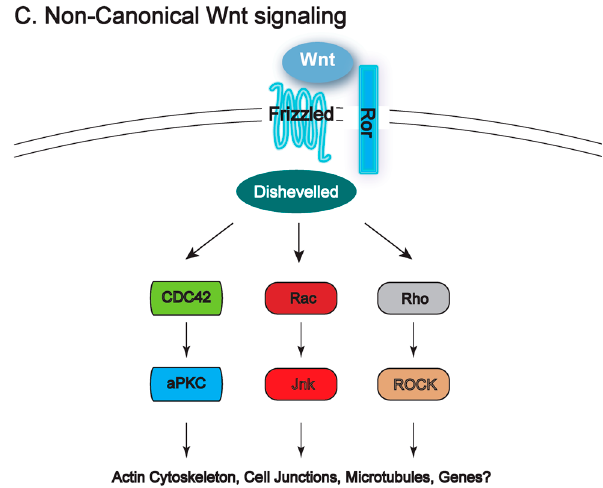
Figure 1. A schematic representation of the Wnt pathway in off ( A ) and on ( B ) conformations and the non-canonical Wnt pathway ( C ). ( A ) In the absence of Wnt ligand, the destruction complex forms in the cytoplasm bringing together APC and Axin, and presenting β -catenin for phosphorylation by CK1 and GSK3. Phosphorylated β -catenin is ubiquitylated and degraded by the proteasome, and does not enter the nucleus where gene expression is repressed by TCF in complex with the repressor Groucho/TLE; ( B ) Upon Wnt ligand binding, the activation complex forms at the membrane where the kinase activity of CK1 and GSK3 is redirected toward LRP5/6 in complex with Axin and Dsh. β -catenin is no longer phosphorylated, enters the nucleus, and takes part in transcription along with TCF; ( C ) The non-canonical Wnt pathway uses a variety of transmembrane proteins like Ror to affect cellular polarity both within the plane of the tissue (PCP) or even within the cell (apico-basal polarity). Figure was adapted from Schlesinger et al. [27].